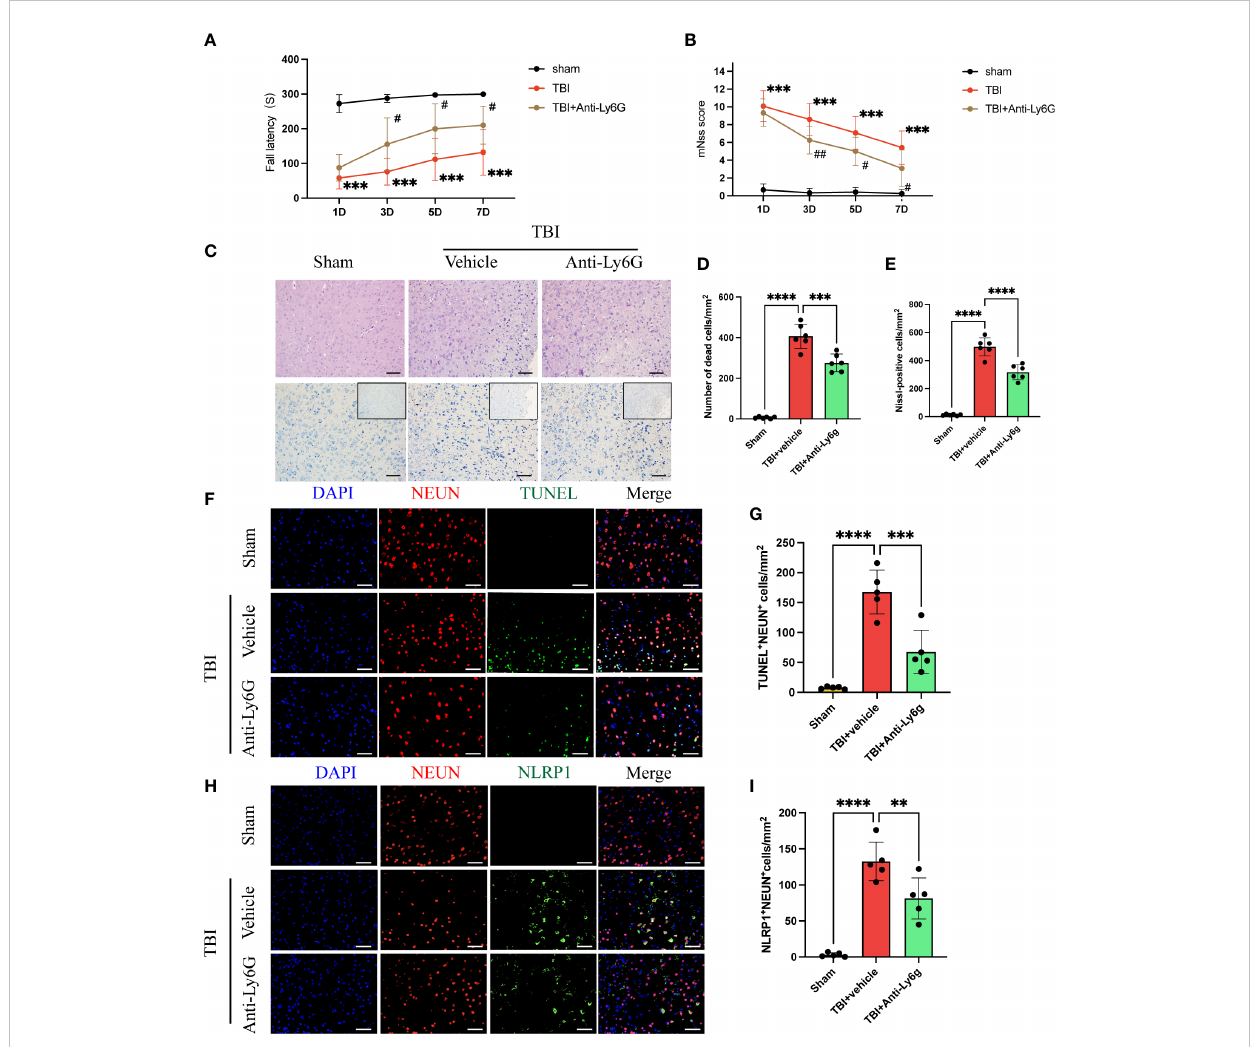
FIGURE 3 Neutrophil depletion ameliorates neurological function and reduces NLRP1-induced neuronal death after TBI. Rotary test (A) and modi fi ed neural severity scores (mNSS, B ) were used to evaluate the neural function of mice treated with vehicle and Anti-Ly6G compared with the Sham group at 1 d, 3 d, 5 d, 7 d after TBI (n = 12). (C) Hematoxylin and eosin staining and Nissl staining of the cortex around the traumatic area 3 days after TBI (n=6). Count the number of dead cells of Hematoxylin and eosin staining (D) and Nissl staining (E) . Scale bar = 100 m m. (F) Representative immuno fl uorescence images of TUNEL-positive(green) cells and NEUN-positive (red) neurons in the peritraumatic cortex (n=6). Count and compare the number of TUNEL-positive neurons in different groups (G) . (H) Representative immuno fl uorescence images of NLRP1-positive(green) cells and NEUN-positive (red) neurons. Count and compare the number of NLRP1-positive neurons in different groups (I) . Nuclei were stained with DAPI (blue). Scale bar = 100 m m. Data are represented as mean ± SD. **P < 0.01, ***P < 0.001 and ****P < 0.0001. compared within two groups. #p < 0.05, ##p < 0.01 and vs vehicle